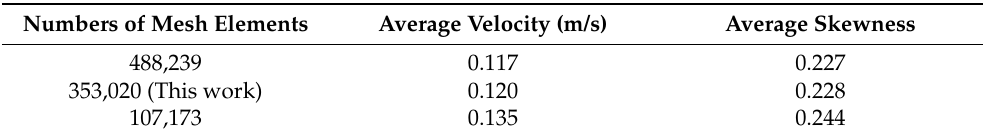
Table 1. The average velocity of the fluid flow and the average skewness depending on the number of mesh elements.